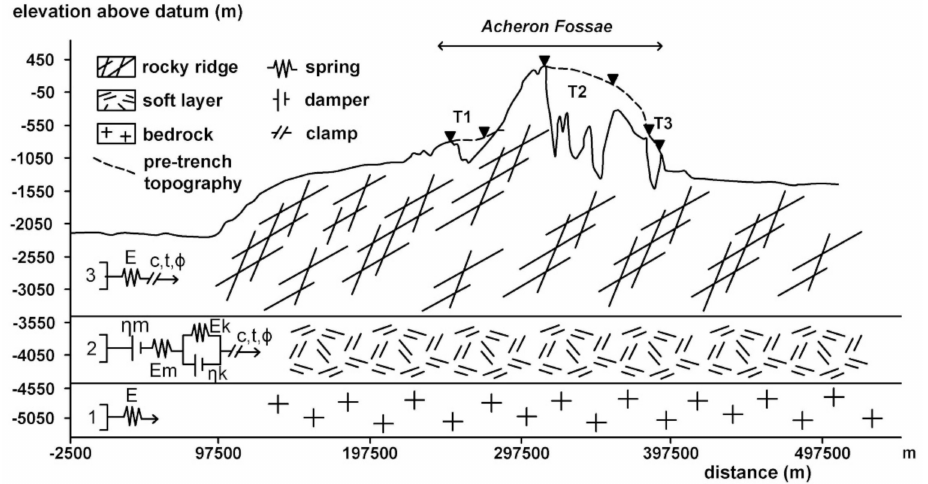
Figure 5. Topographic profile of the DSGSD in Acheron Dorsum along the eastern cross-section, with indication of the relative rheological schemes used for the three layers in the numerical modelling; redrawn after De Blasio and Martino [70]. As showed by numerical modelling, the large-scale gravitational deformation was guided by the rheological contrast between the rigid rocky layer and the underlying soft and viscous